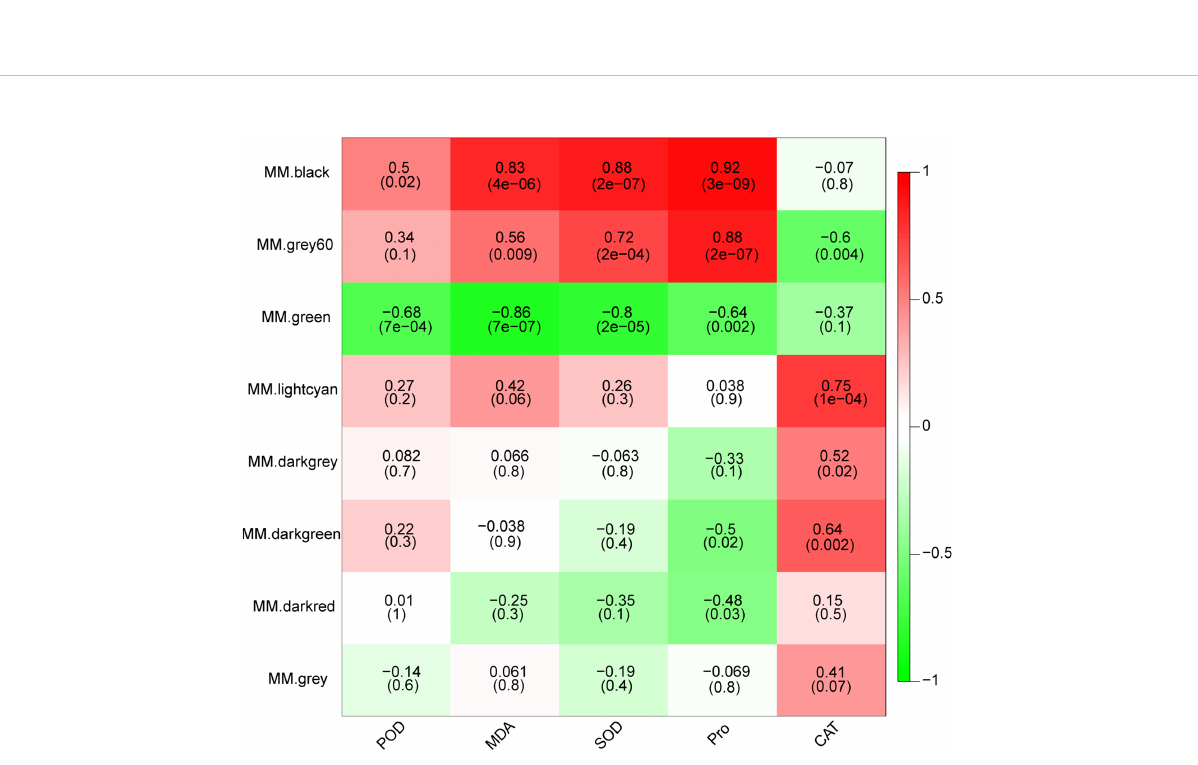
FIGURE 3 Character correlation diagram of physiological indicators. The horizontal coordinates indicate the character and the vertical coordinates indicate the module, which is plotted with Pearson correlation coef fi cient. Red represents positive correlation and green represents negative correlation. The darker the color, the stronger the correlation. The number in the brackets below represents signi fi cance P -value. The smaller the value, the stronger the signi fi